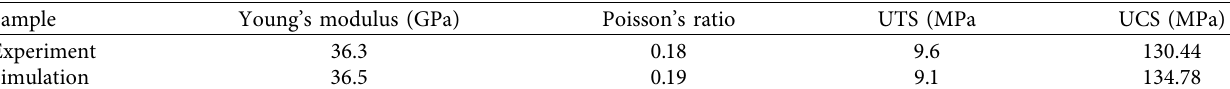
Table 2: Comparison of macroscopic mechanical parameters between experiments [14] and simulations.